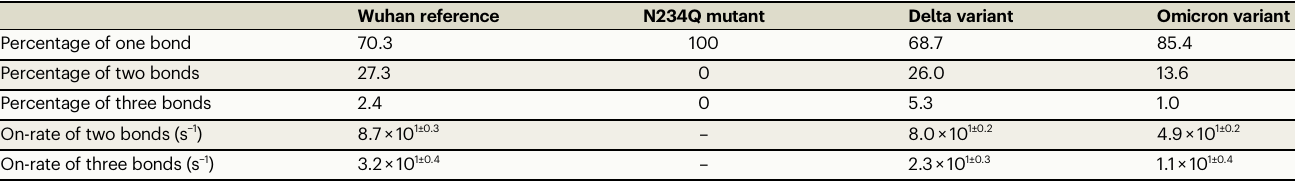
Table 2 | Percentage and on-rate of two or three bonds from Spikes of Wuhan reference, N234Q, Delta,and Omicron (B.1.1.529) variant Wuhan